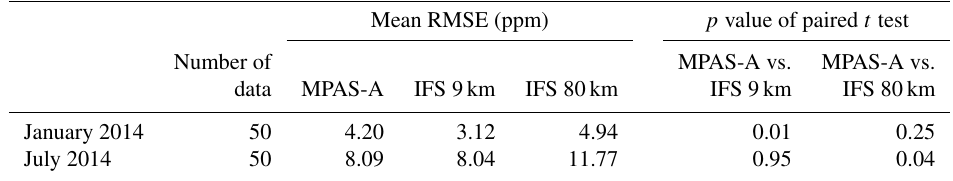
Table 5. Comparison of mean RMSE of hourly CO 2 from MPAS-A and IFS 9km and 80km simulations. p values of the paired t test between MPAS-A and the IFS simulations are also listed.